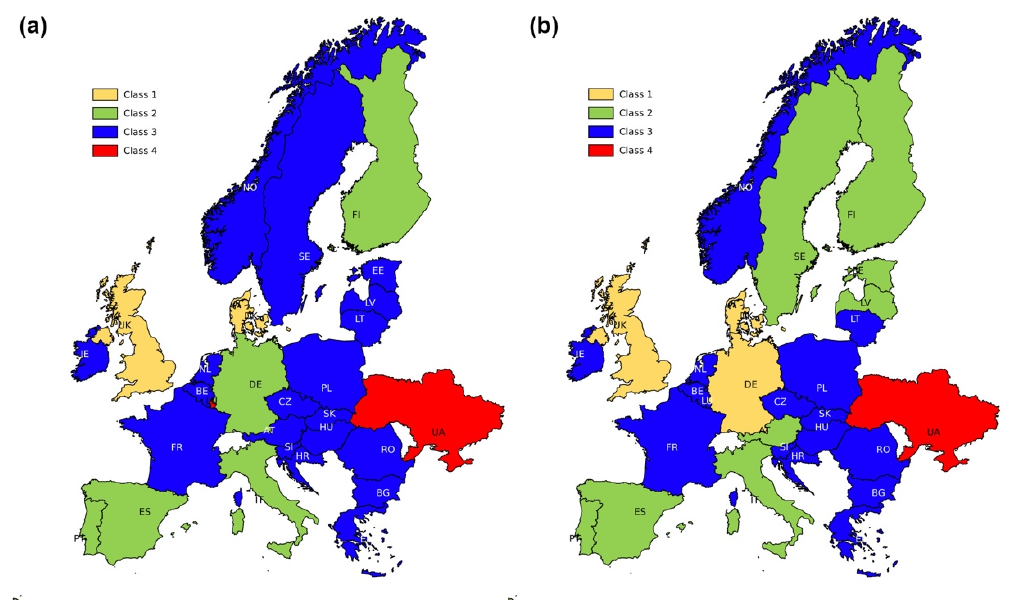
Figure 9. Classification results (VMCM) of European countries for real pattern (UK) and anti-pattern (UA) of 2018: ( a ) 2014; ( b ) 2018.